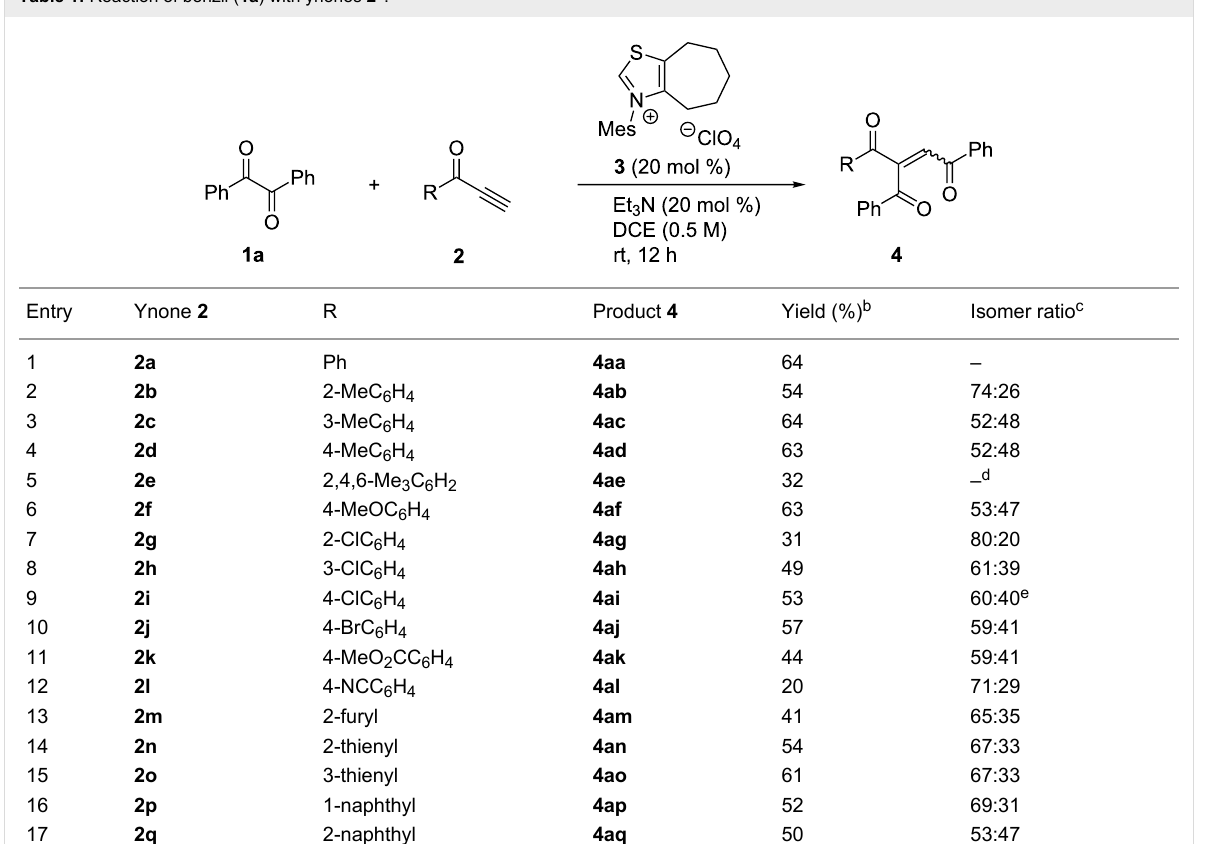
Table 1: Reaction of benzil ( 1a ) with ynones 2 a